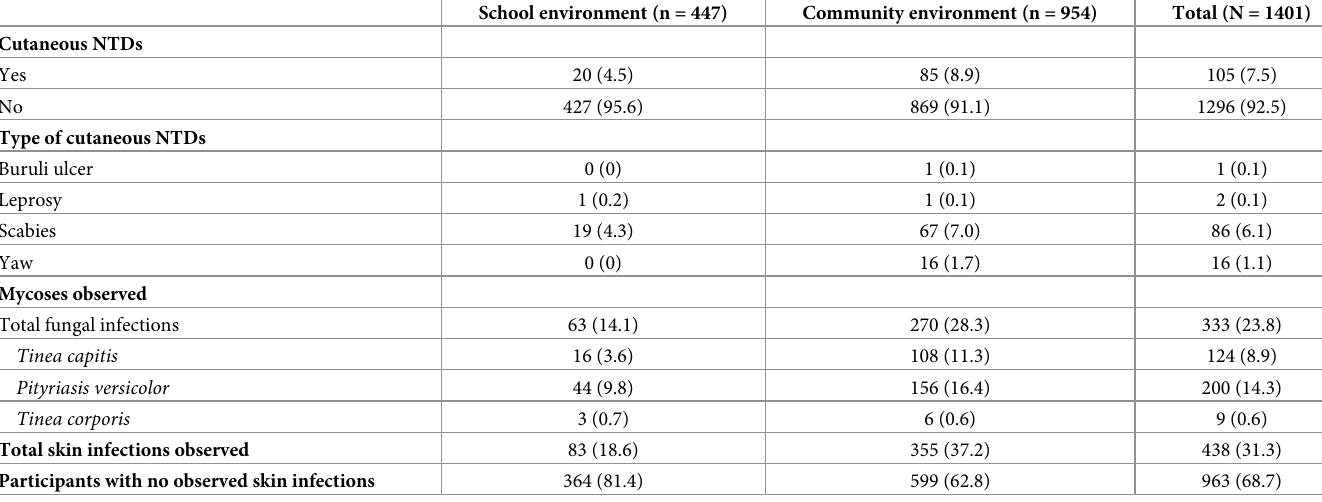
Table 1. Skin NTDs and mycoses observed, N